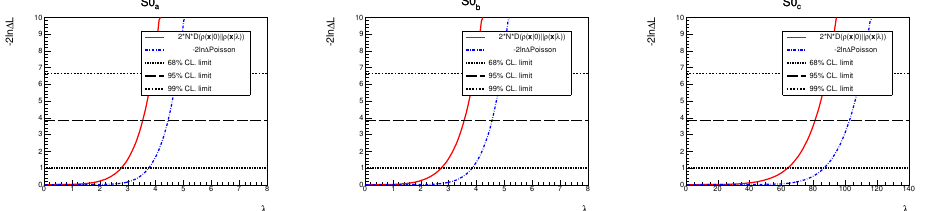
Figure 14 . Upper limits on the coupling strength parameters of the S0 benchmark scenarios.